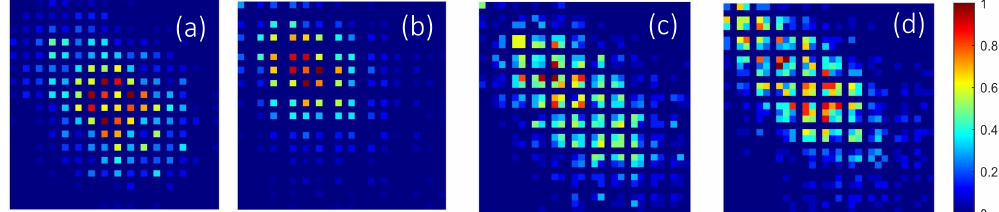
Figure 4. Representative normalized co-occurrence matrices computed in horizontal-vertical directions from cell density maps: ( a , b ) correspond to ADC studies, and ( c , d ) to SCC studies. Note the more homogeneous pattern in SCC with smoother variation in cooccurrences compared to ADC.